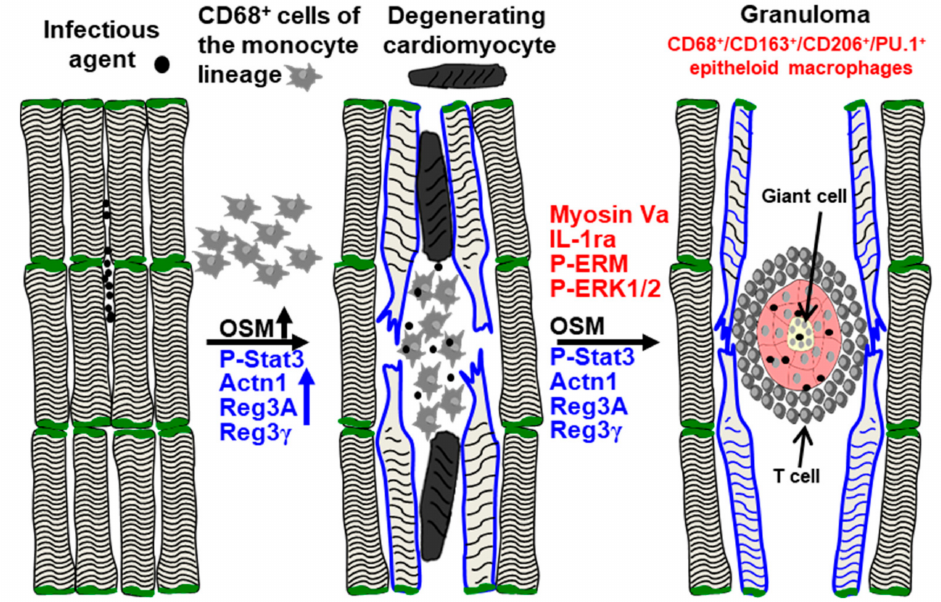
Figure 7. Hypothetical scheme of the formation of cardiac granulomata and the development of a vicious cycle by the activation of the OSM/OSMR/Stat3/Reg3 axes. Infectious signals evoke an infiltration of CD68 + monocytes/macrophages which release oncostatin M, which induces the activation and remodeling of cardiomyocytes (P-Stat3, Actn1, elongated sharp cell shape), and an accumulation of monocytes/macrophages through the release of regenerating islet-derived proteins (Reg3A and Reg3 γ ). The incomplete removal of infectious signals leads to chronic infiltration, the formation of highly active granulomata, cardiomyocyte degeneration and fibrosis in affected myocardial